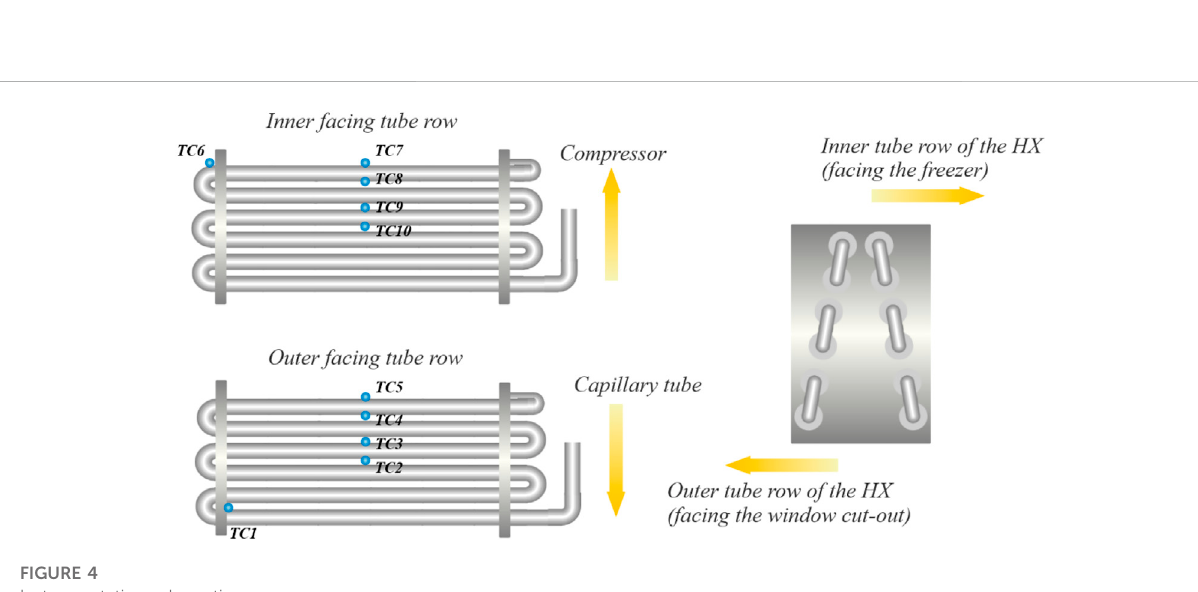
FIGURE 4 Instrumentation